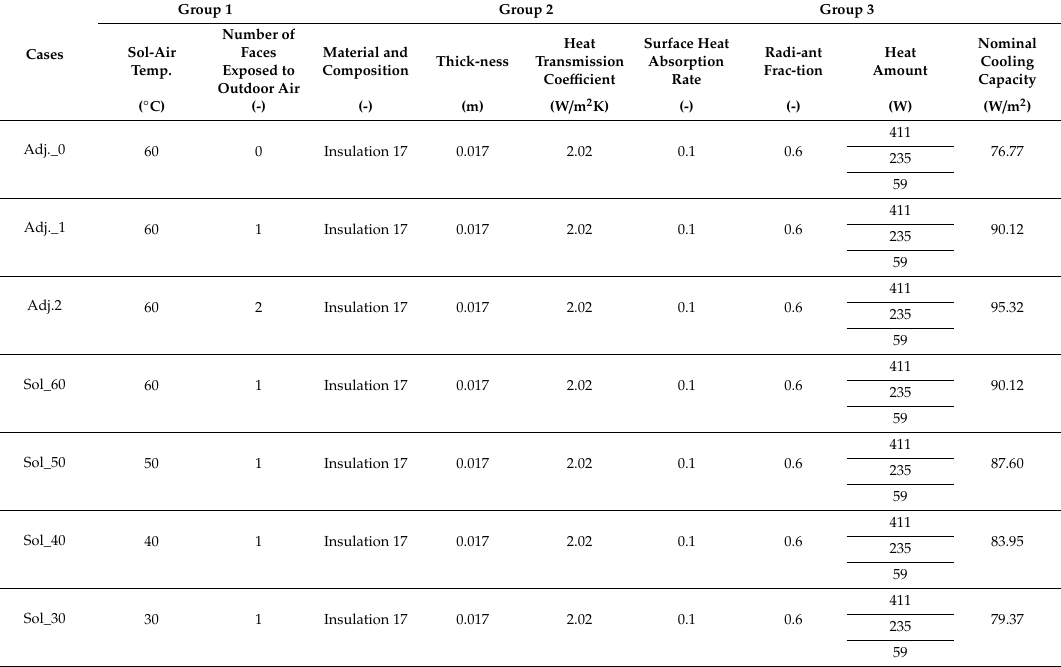
Table 16. Cooling capacity according to site and building.